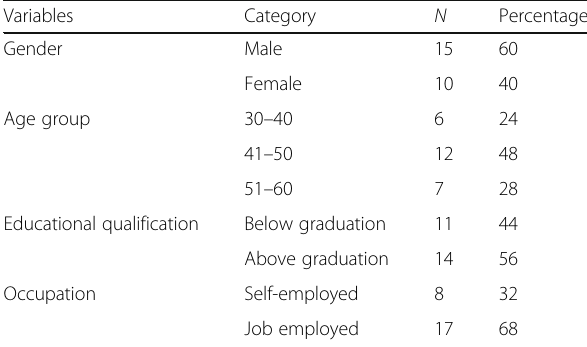
Table 1 Background details of the subjects showing variables, number of subjects who belongs to a particular category